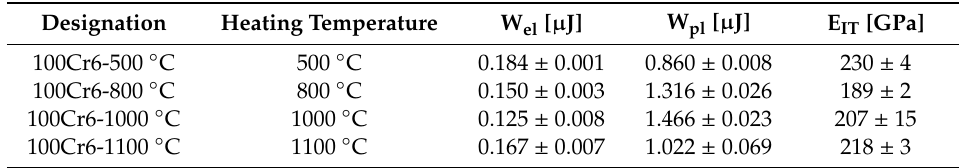
Table 2. Results of the performed microhardness measurements: values describing the deformation behavior measurements.